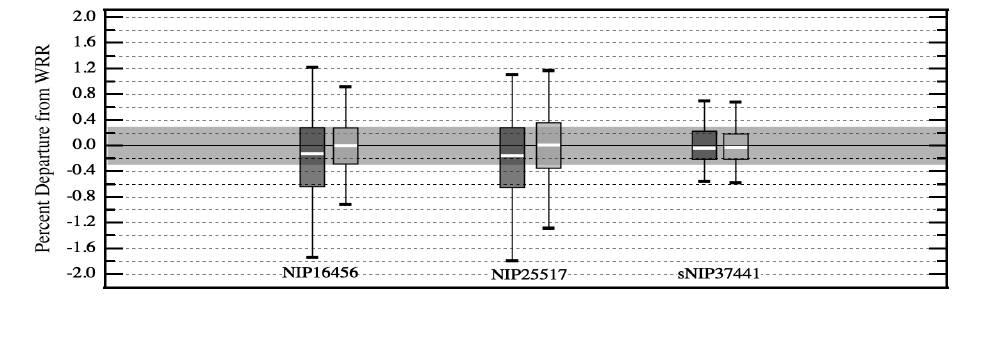
Figure 7. Results for three working class pyrheliometers used to collect clear sky solar irradiance data from 16 May 2013 to 12 August 2013. Sampling rate was 1 hertz and data were processed into one minute averages. A total of 14914 data points are included in the data set. Solar zenith angle range: 16–84 degrees Irradiance range: 375–1050 watts per square meter. Darker shaded boxes are residual summaries of ratio responsivity scaling. The lighter shaded boxes are residual summaries of a linear model scaling of pyrheliometer outputs. Box and whisker information is the same as in Figures